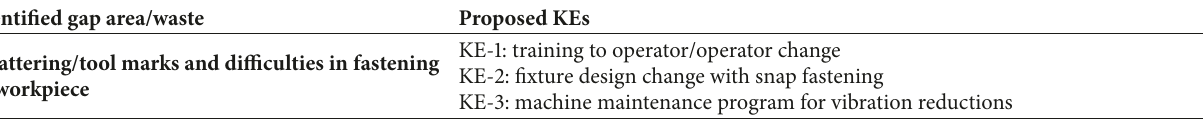
Table 2: Proposed KEs for identified gap areas/waste.